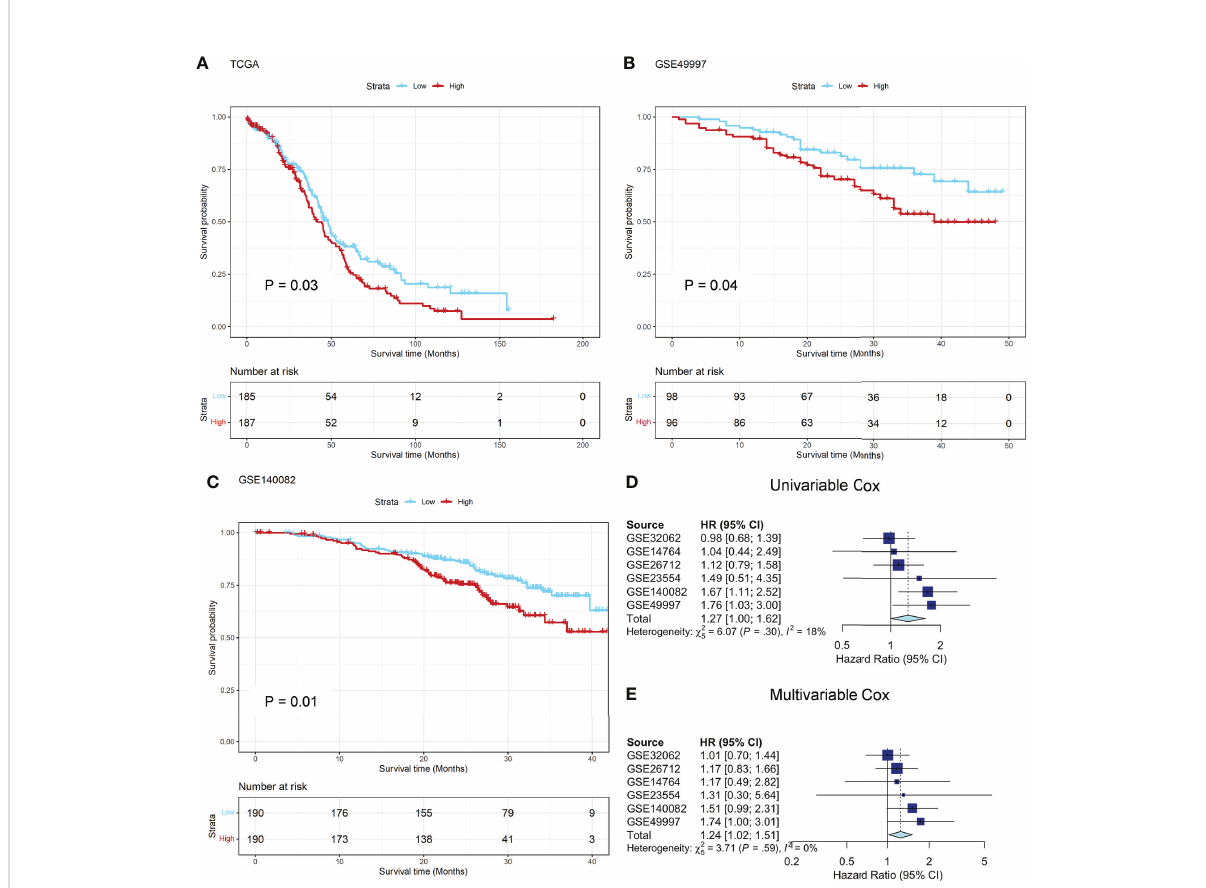
FIGURE 2 Prognostic analysis in TCGA and GEO datasets. (A) The Kaplan-Meier survival curves of OS between the ADO groups in the TCGA training dataset; (B, C) The Kaplan-Meier survival curves of OS between the two ADO groups in the GSE49997 and GSE140082 validation datasets, respectively; (D, E) The forest plot of the meta-analysis on the results of 6 GEO validation dataset calculated by using univariate and multivariate Cox model,